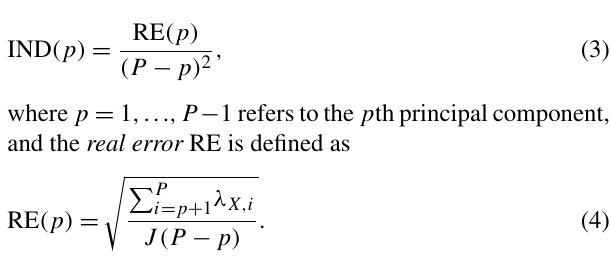
ited number of principal components, defined by Turner et